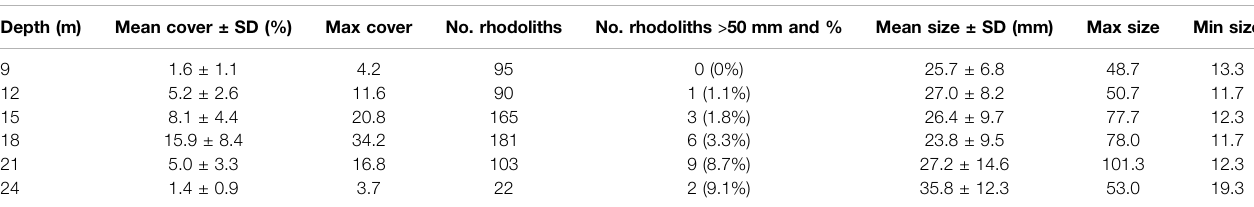
TABLE 3 | Rhodolith cover (%) and size (mm) by